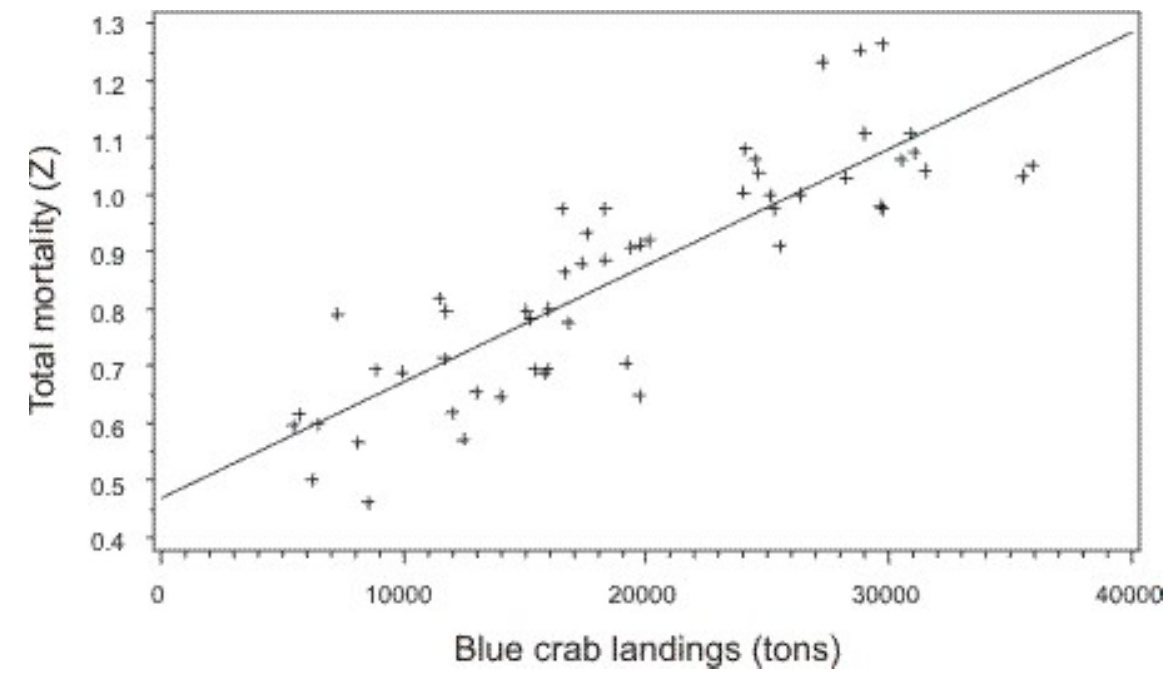
Fig. 5. Fishery-independent estimates of total mortality as a function of blue crab landings in the trap fishery, with the linear trend. The linear trend was modeled using linear regression: y = 1.621 × 10 0.55; R² = 0.56, p <